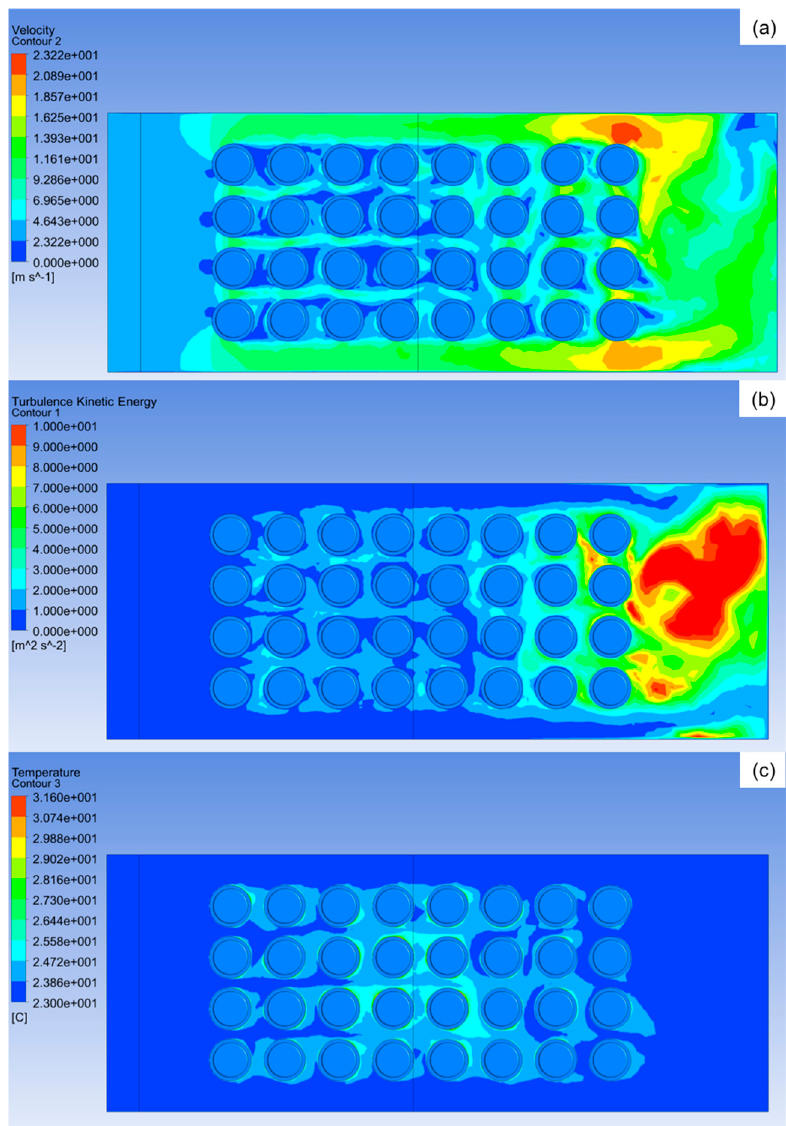
Figure 11. Contours of ( a ) velocity, ( b ) turbulence kinetic energy, and ( c ) temperature in the horizontal plane at 52 mm from the bottom of the battery pack for Case 1 (baseline configuration).